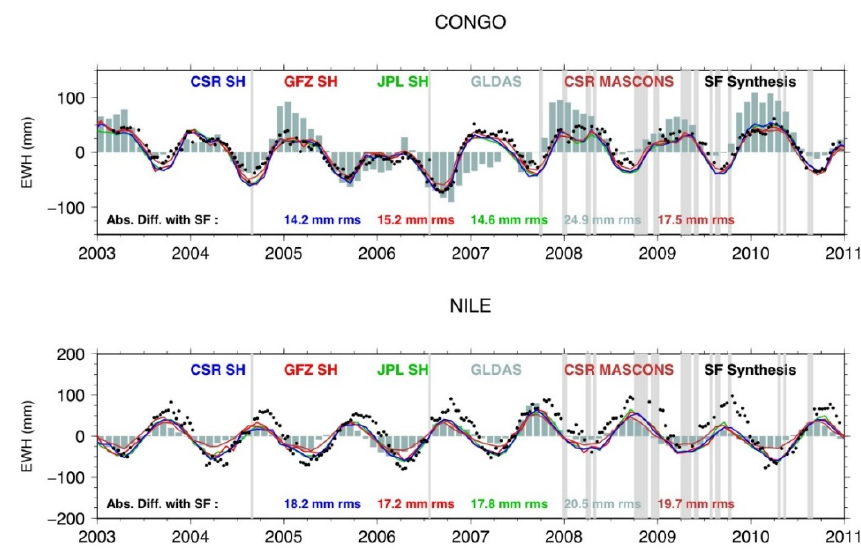
Figure 6. Reconstructed Slepian time series for the Congo (up) and Nile (down) watersheds which are compared to the profiles given by GLDAS (light blue grey), and the SH solutions of the main centers, i.e., CSR (blue), JPL (green), GFZ (red), CSR mascons (brown). Some data gaps due to noisy orbit or of bad quality are shown using vertical lines (light grey). Root Mean Square (RMS) values of the absolute differences with the SF time series are also indicated by the processing center.